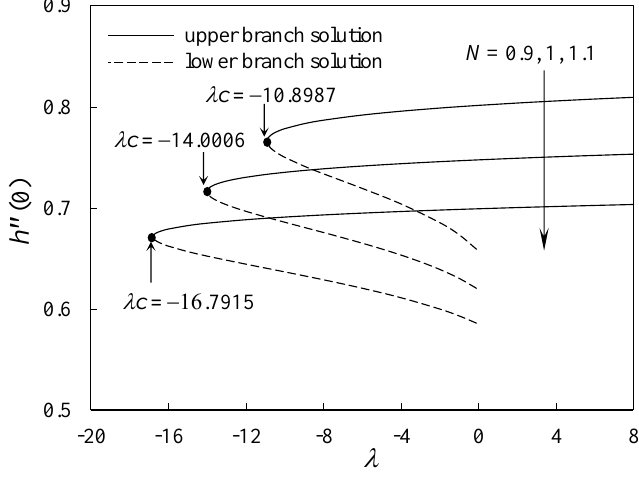
-8   0 h    0 h  Figure 5. Variation of h (cid:48)(cid:48) ( 0 ) with λ for several values of N for Ag-water Figure 5. Variation of with  for several values of N for Ag-water nanofluid. Figure 5. Variation of with  for several values of N for Ag-water nanofluid.